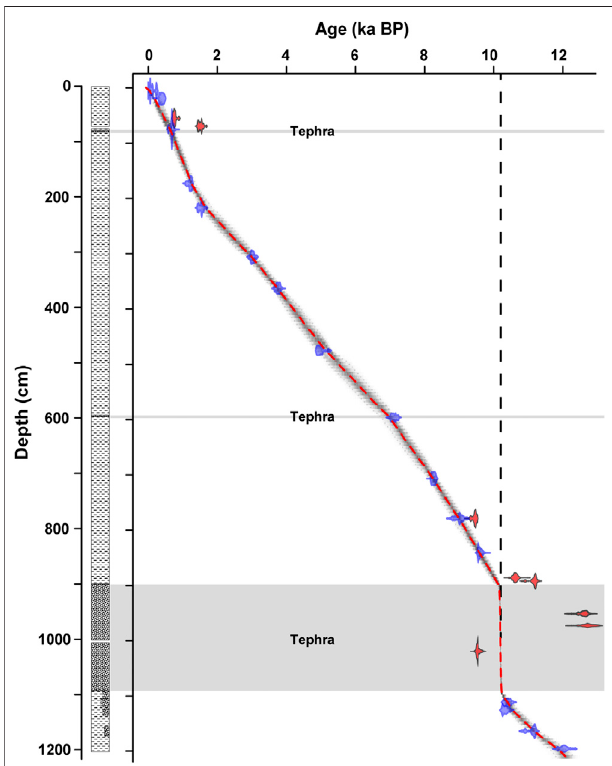
FIGURE 2 | Age model for Lake Dendi core composite. Bayesian age- depth modeling was based on 24 radiocarbon dates applying a reservoir correction of 329 years (Wagner et al., 2018). Radiocarbon ages in red were discardedfromthecalculationoftheagedepthcurve.Graybarsindicate tephra